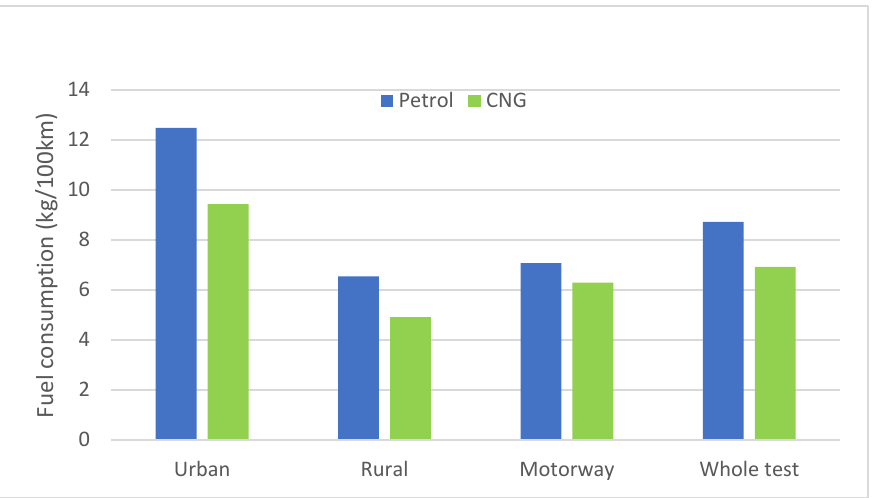
Figure 21. Comparison of the fuel consumption between the vehicle fueled with petrol and CNG in the on-road test.